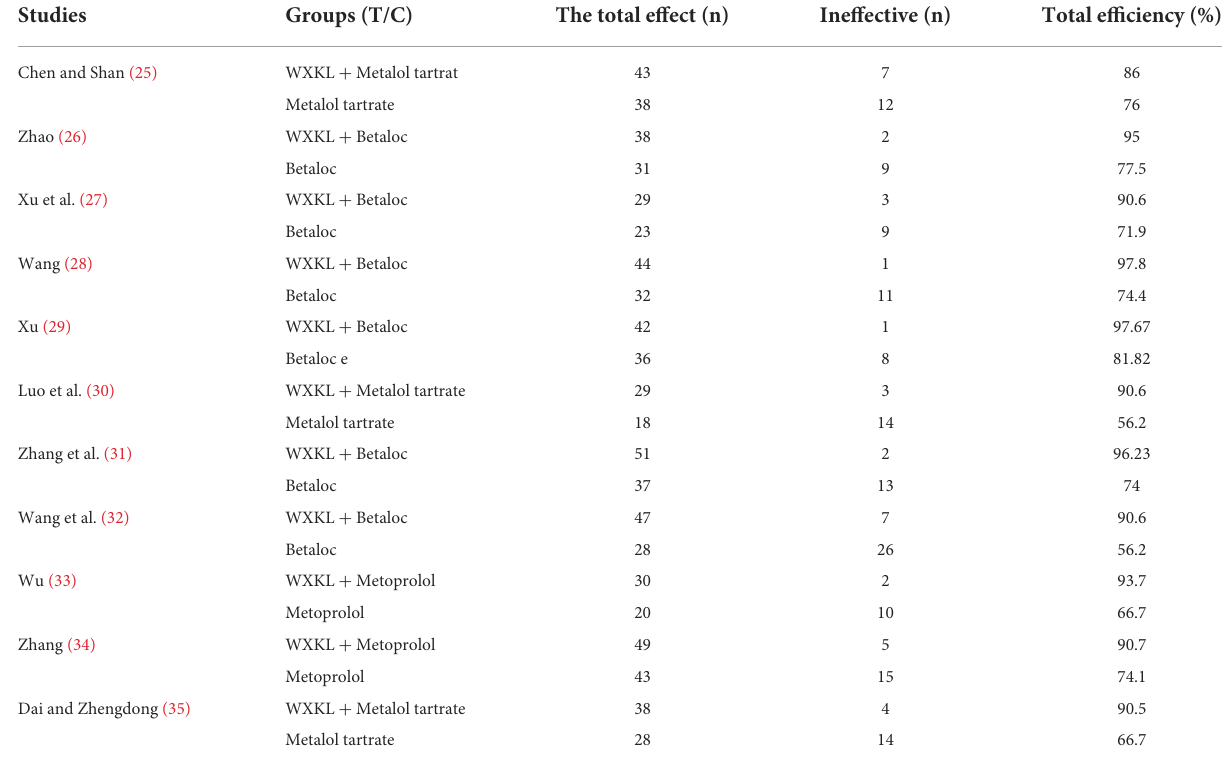
Outcomes:a.Clinicalefficacy;b.24helectrocardiogram;c.Subjectiveadversereactions(dizziness,nausea,etc.).d.Liverandkidneydamage. TABLE 3 Clinical efficacy of premature ventricular